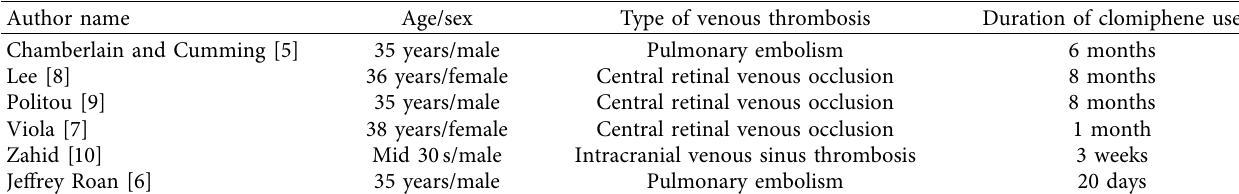
Table 1: Previously reported case reports of venous thrombosis associated with